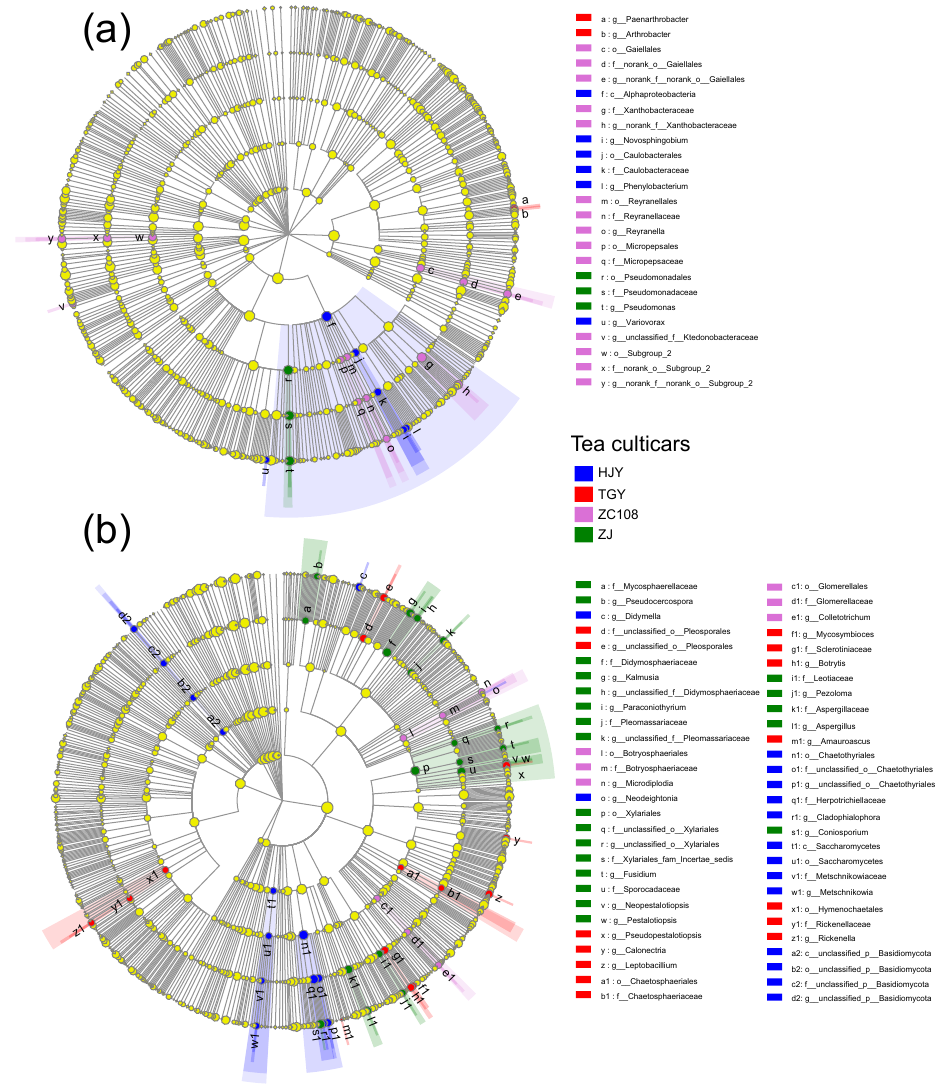
Figure 5. Linear discriminant analysis (LDA) effect size (LEfSe) taxonomic cladogram highlights the bacterial ( a ) and fungal ( b ) biomarkers in soils with four different tea plant cultivars. Four tea